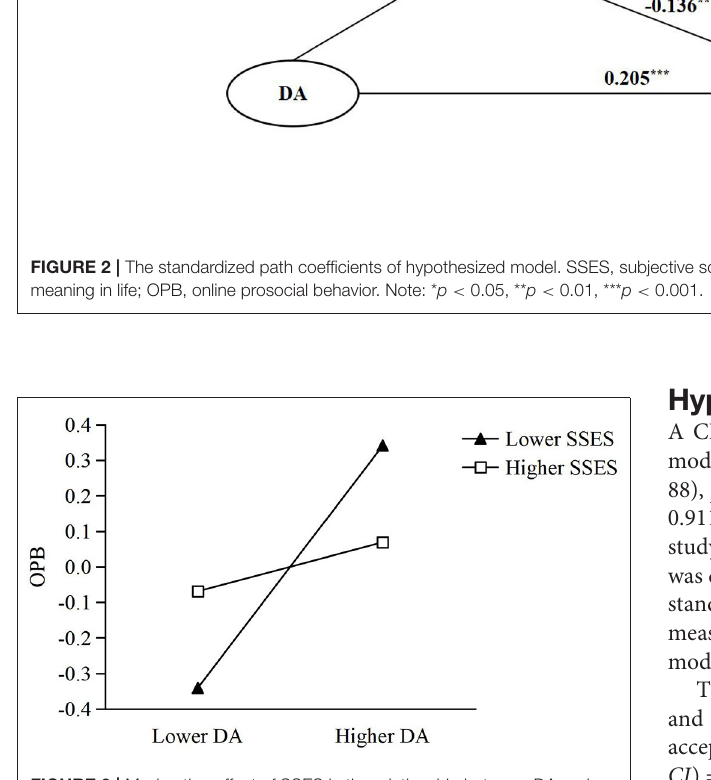
FIGURE 3 | Moderation effect of SSES in the relationship between DA and OPB. SSES, subjective socioeconomic status; DA, dispositional awe; OPB, online prosocial